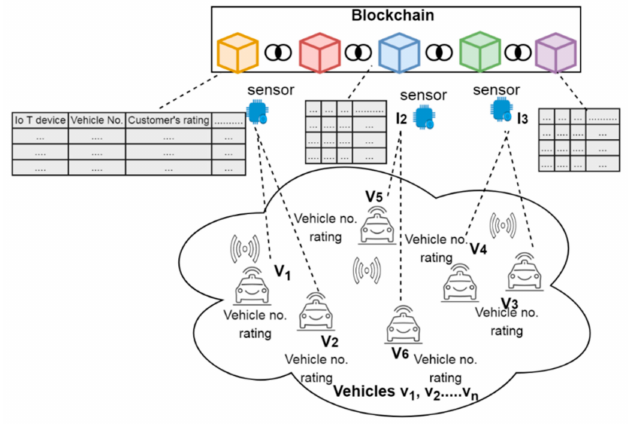
Figure 2. The architectural framework of a connected vehicle